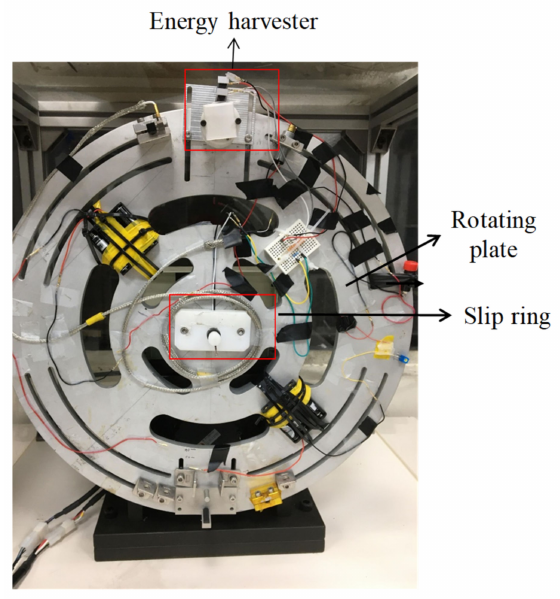
Figure 20. Experimental setup for energy harvesting.